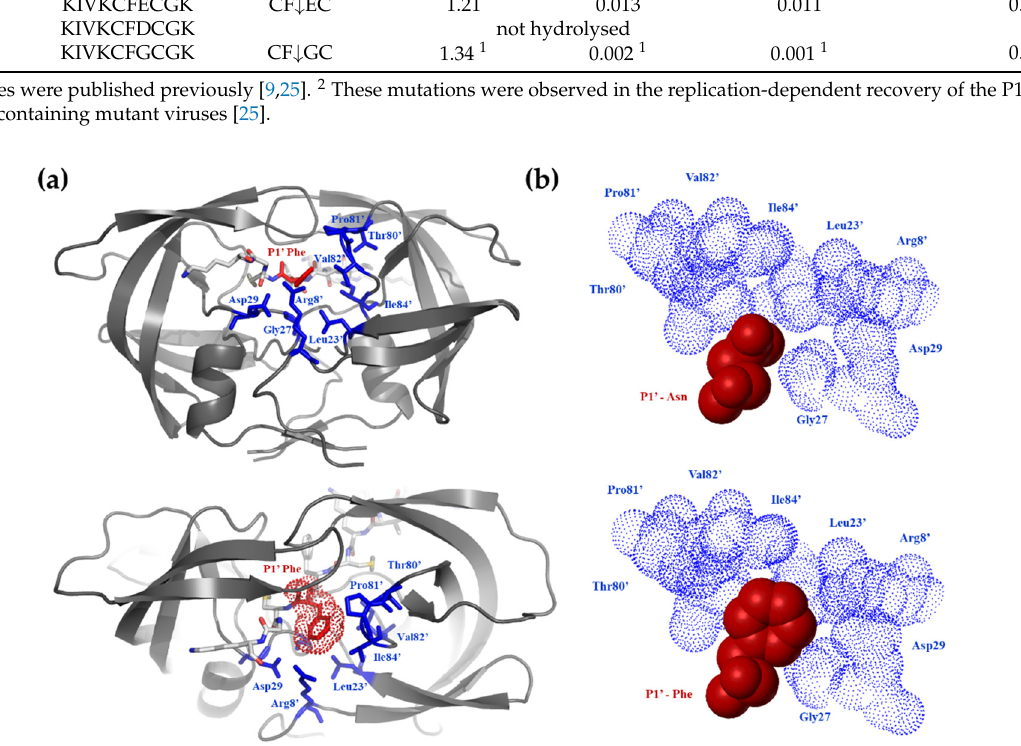
Figure 2. Fitting of Asn and Phe residues into the S1 substrate binding site of HIV-1 protease. ( a ) The structure of HIV-1 PR complexed with KIVKCFFGCK oligopeptide substrate. The S1 ′ and P1 ′ residues are shown by blue and red colours, respectively. ( b ) In contrast to the wild-type P1 ′ -Asn, the P1 ′ -Phe residue of mutant NC-1 sequence was expected to provide favourable hydrophobic in- teractions at the S1 ′ subsite.